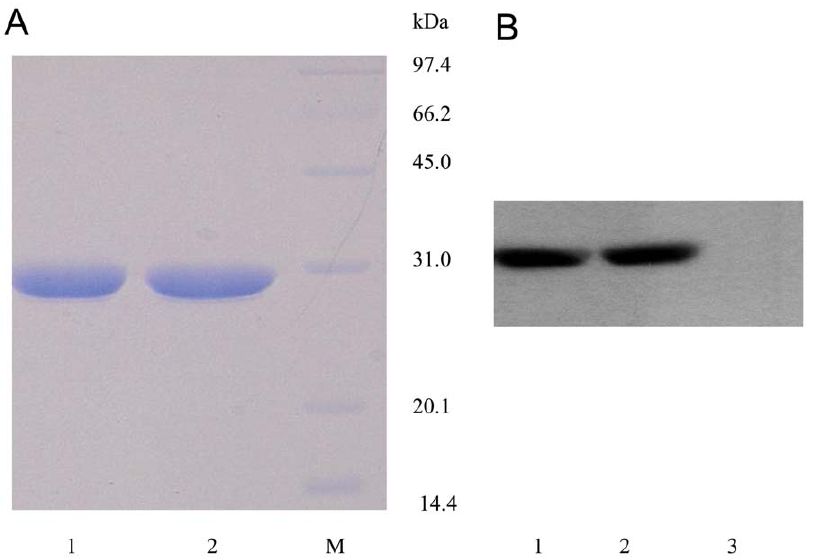
Figure 2. Characterization of mSEB. (A) SDS-PAGE analysis of wtSEB and mSEB. Lane 1, purified wtSEB; Lane 2, mSEB; and Lane M, low molecular weight protein marker. (B) Western blot analysis of wtSEB and mSEB using anti-SEB mAb, followed by signal enhancement using the ECL detection system. Bovine serum albumin (BSA) was used as a negative control. Lane 1, wtSEB positive control; Lane 2, mSEB; Lane 3, BSA.